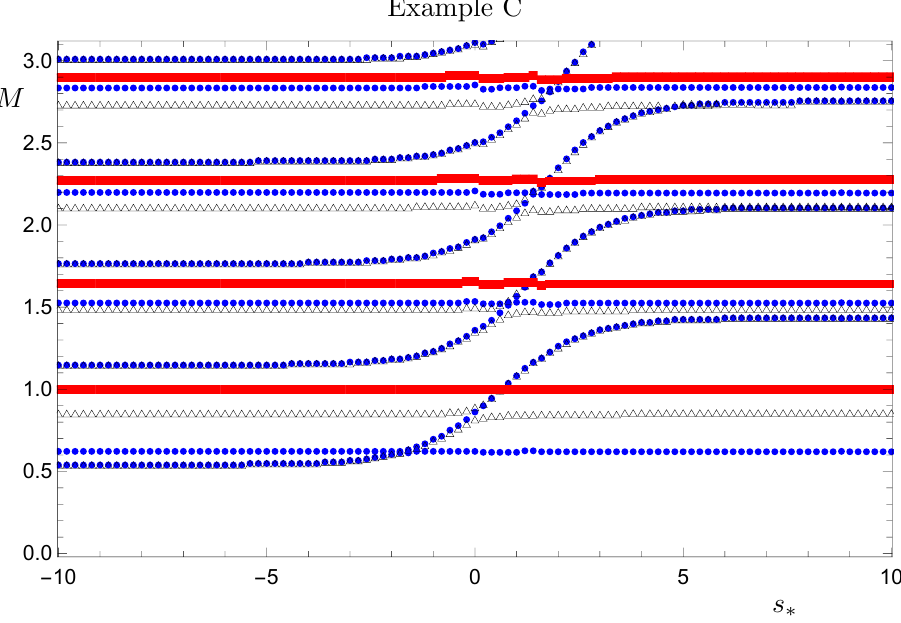
p Figure 4 . Masses M = (cid:0) q 2 of modes in the circle reduction of Romans theory, as a function of the parameter s . All masses are expressed in units of the mass of the lightest tensor mode. The (cid:3) (red) squares represent the tensor modes, the (blue) circles are the scalar modes, computed with the complete, gauge-invariant variables, while the (black) triangles are the scalar modes computed by making use of the probe approximation. We notice that in probe approximation, and for large values of s , two of the towers of scalar states become so close to degenerate that in our numerical (cid:3) study we could not resolve them, and they are represented by just one set of points. In the numerical calculations (cid:26) 1 = 0 : 001 and (cid:26) 2 =